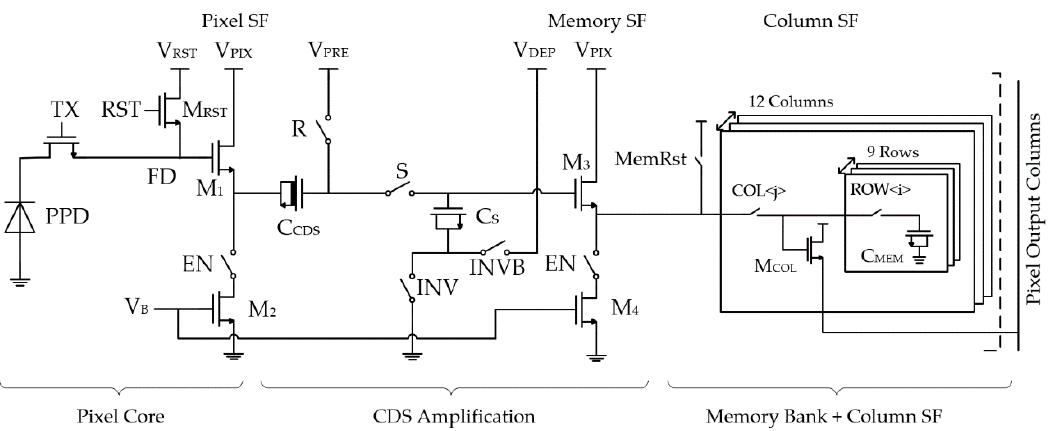
Figure 4. Pixel schematic (Type A).